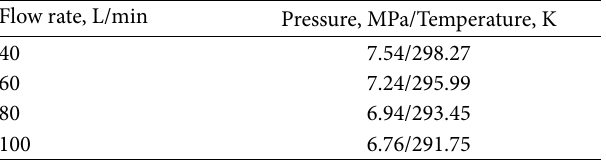
Table 2: Flow rate‐pressure/temperature.